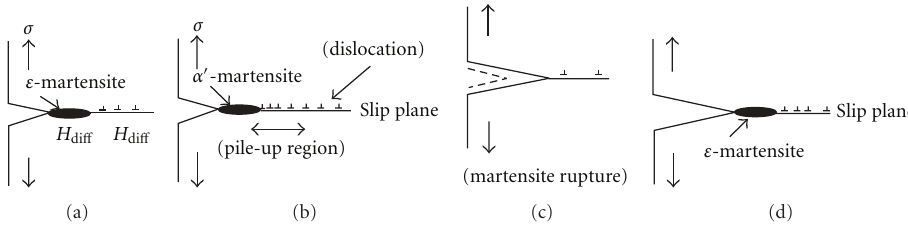
Figure 7: Schematic representation of a transgranular hydrogen embrittlement caused by the formation of α (cid:2) -martensite and dislocation